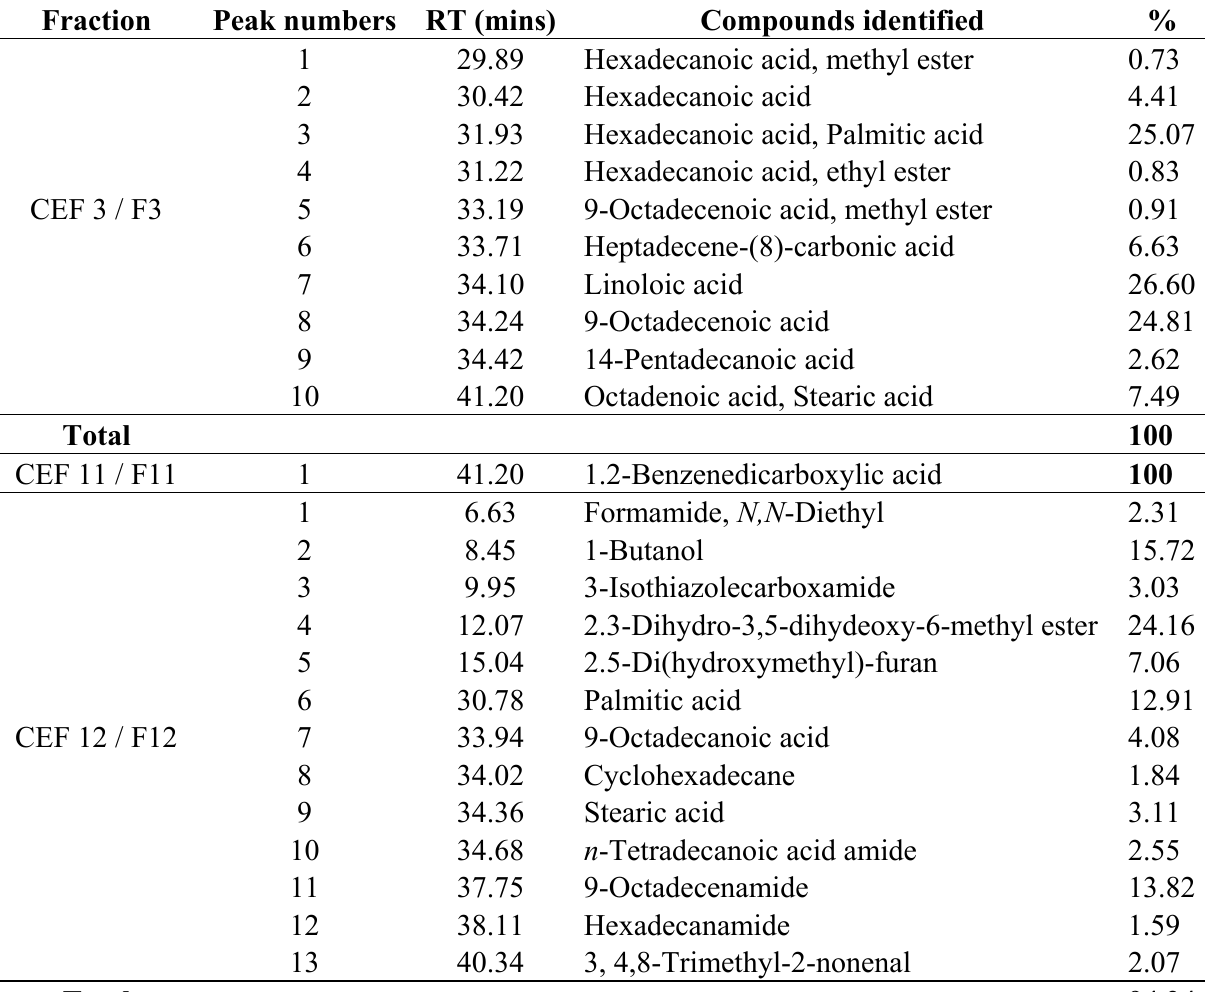
Table 6. Phytochemicals of the CEF fractions of Garcinia kola